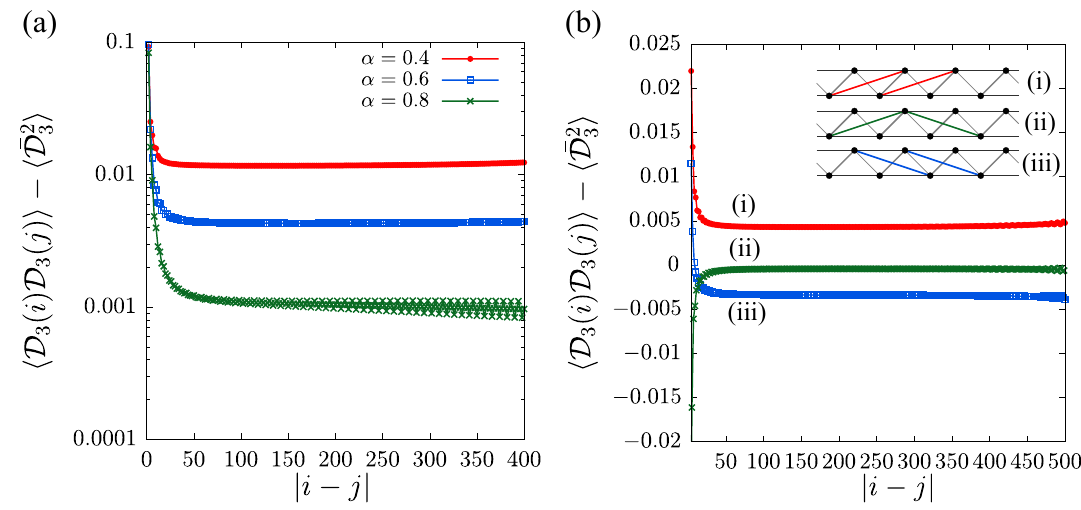
( i ) ( i ) 〉 as a function of distance | i − j D 3 D 3